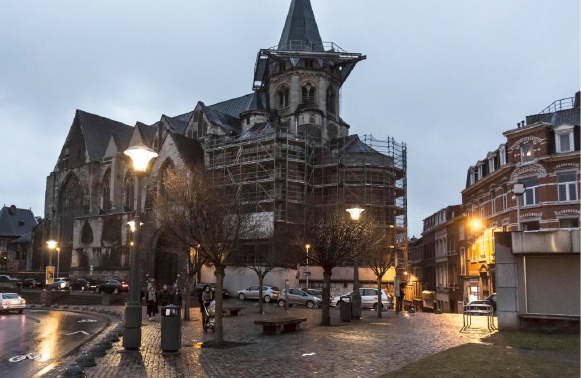
Figure 1 . View from the collegiate church Sainte Croix of Liège, Belgium (© M.